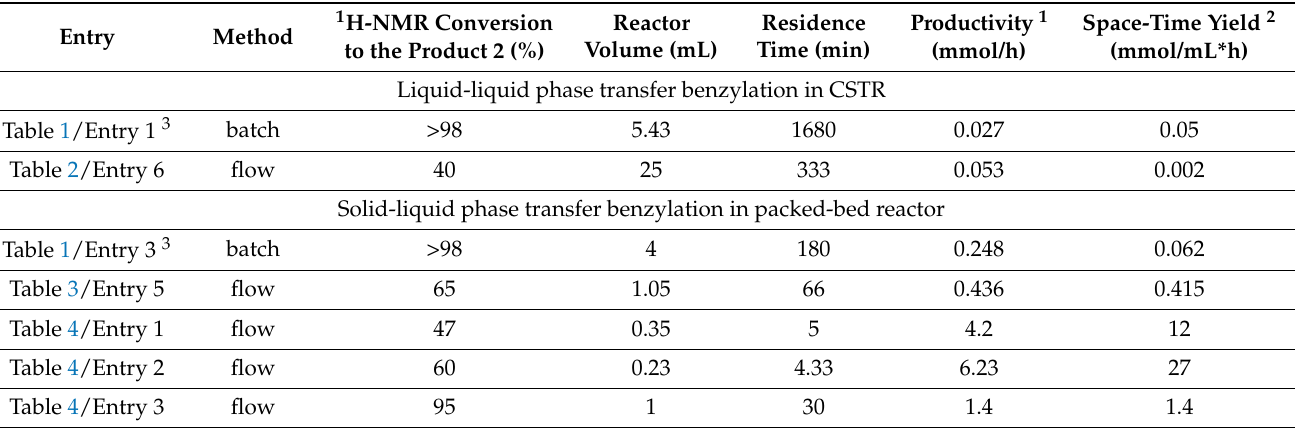
Table 5. Comparison of productivity and space-time yield in flow and in